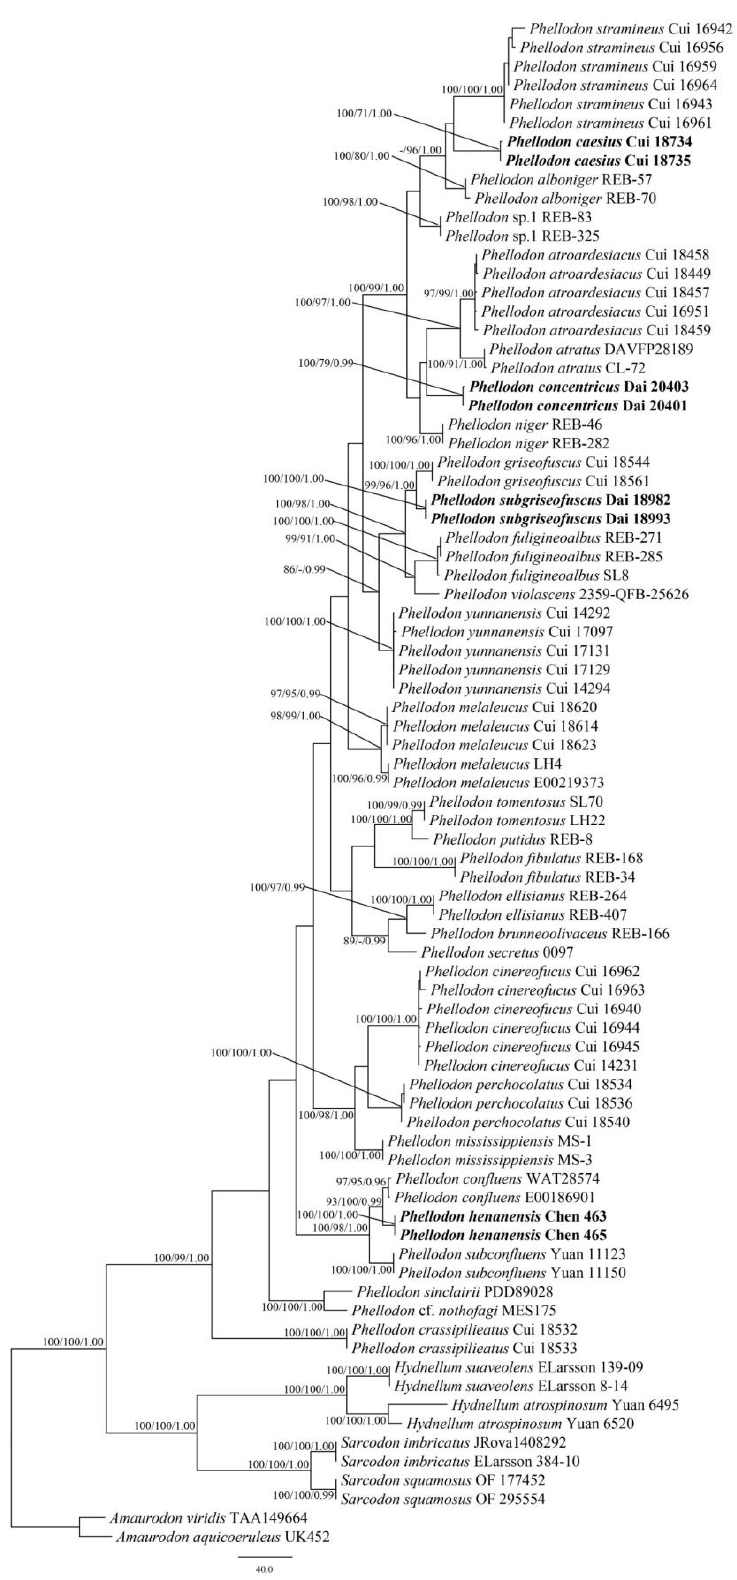
Figure 1. Maximum parsimony (MP) phylogram of the Phellodon species based on ITS + nLSU sequences data. The supported branches are labeled with parsimony bootstrap values higher than 50%, maximum likelihood bootstrap values higher than 50%, and Bayesian posterior probabilities more than 0.95. Bold names = New species.